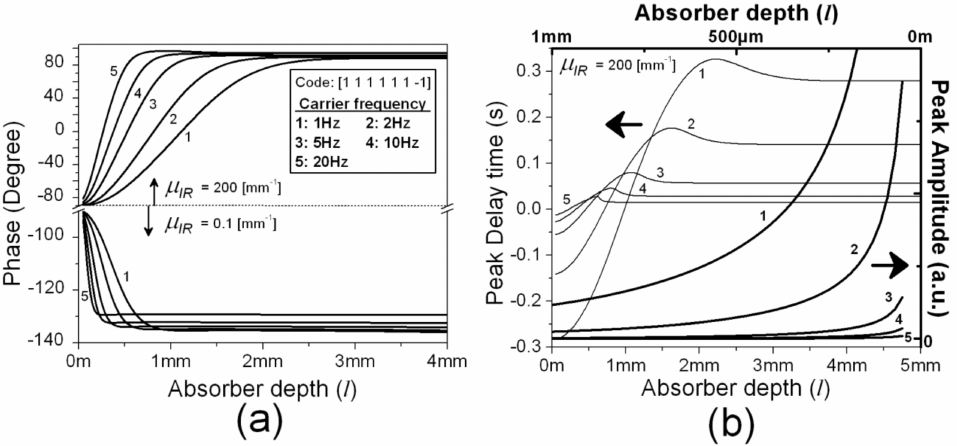
Figure 8. Theoretical CC ( a ) phase; ( b ) peak delay time (left and bottom axis) and amplitude (right and top axis) curves as a function of the subsurface absorber depth using properties of dental enamel: µ a = 100 [m − 1 ], µ s = 6000 [m − 1 ], g = 0.96, r = 0.65, k = 0.9 [Wm − 1 k − 1 ], α = 5 × 10 − 7 [m 2 s − 1 ]. The numbers accompanying the curves determine the carrier frequency according to the inset of part ( a )